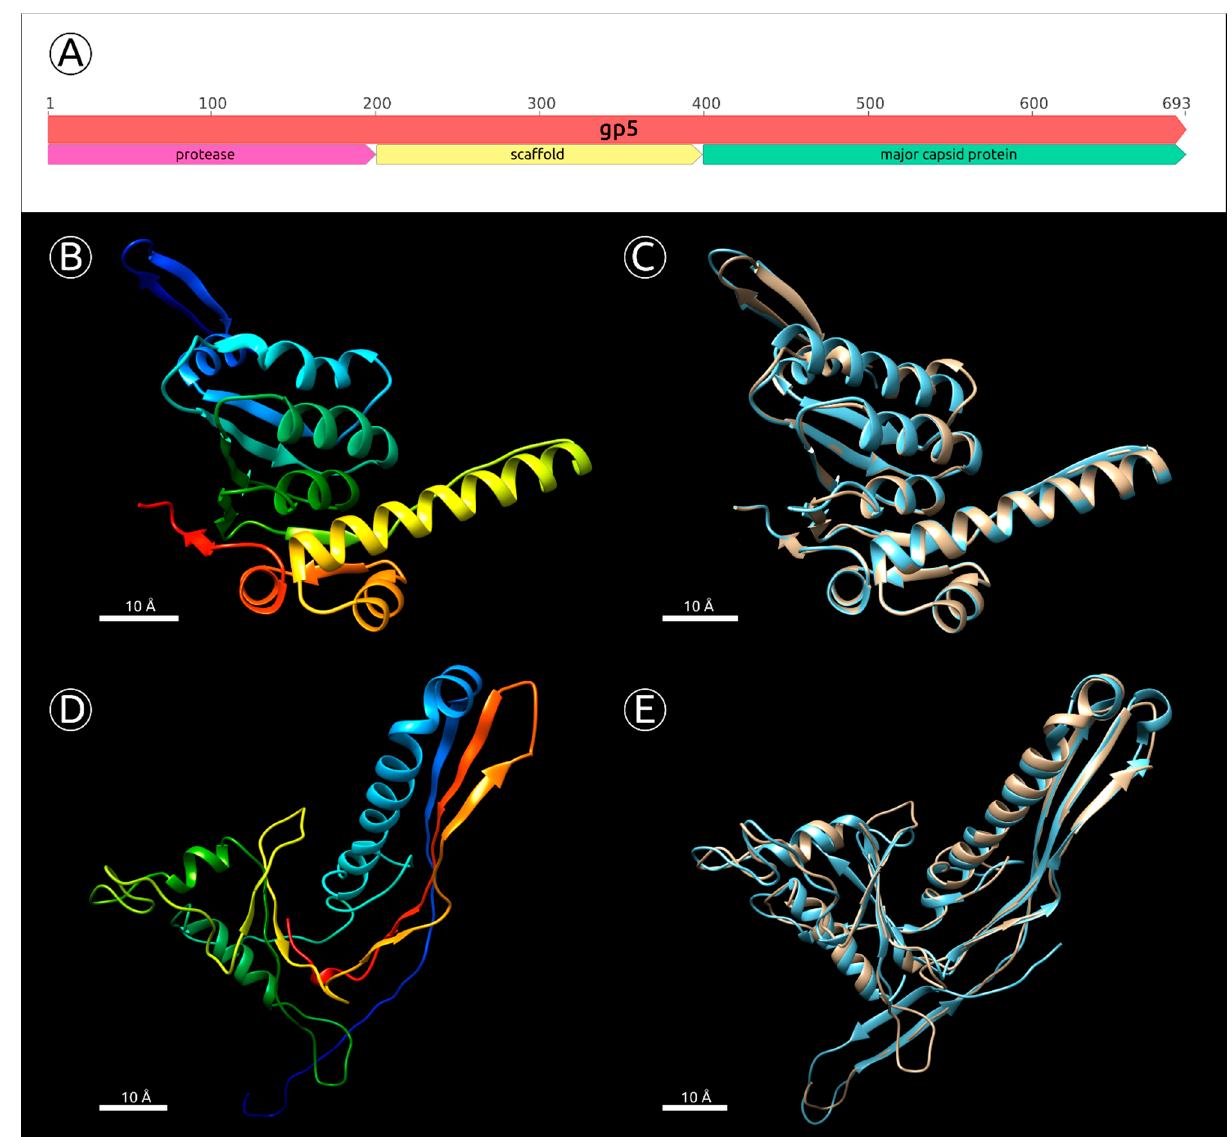
Figure 6. ( A ) Approximate positions of the gene 5 domains encoding protease, scaffolding protein and major capsid protein. ( B ) Predicted by the homology modelling tertiary structure of MD8 protease domain (gp5 amino acid residues 16–204, confidence 100%, template PDB accession 3Q7H). ( C ) Structural alignment of the predicted MD8 protease domain and ClpP subunit of the ATP-dependent Clp Protease from Coxiella burnetii used as a template. ( D ) Predicted by the homology modelling tertiary structure of MD8 MCP domain (gp5 amino acid residues 456–690, confidence 100%, template PDB accession 1IF0). ( E ) Structural alignment of the predicted MD8 protease domain and Bacteriophage HK97 procapsid used as a template. The scale bar is 10